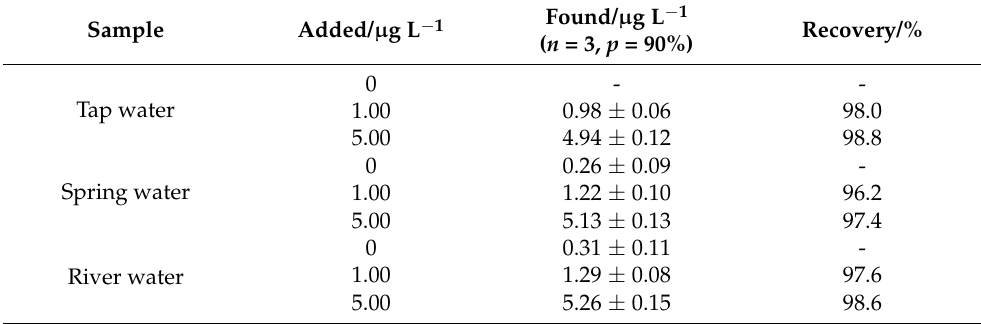
Table 4. Analytical results of trace Cd(II) in natural water samples.